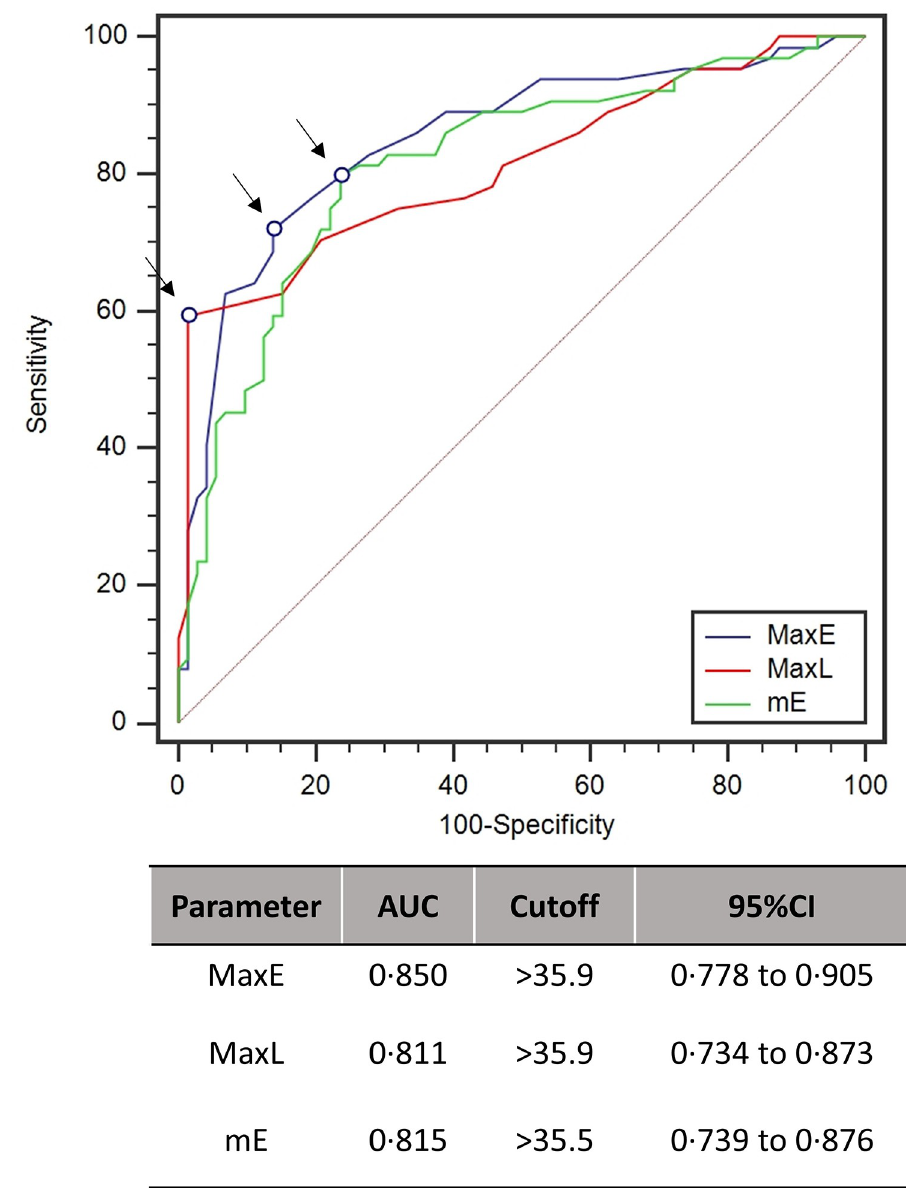
Fig 4. Receiver operator characteristics (ROC) curve with the best IRT parameters. Performance of each parameter is compared through their respective areas under the curve (AUC), 95% confidence intervals are also provided. Arrows indicate the criterion cutoff points. MaxE (maximum temperature of the Eyes), MaxL (maximum temperature of the lateral of the nose), mE (mean temperature between the